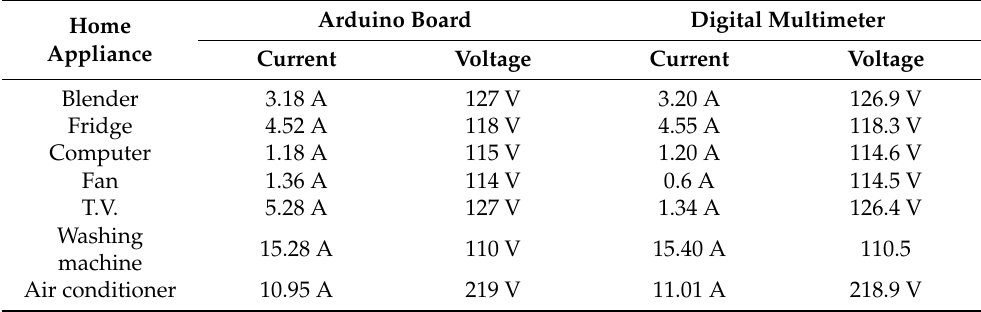
Table 3. Energy consumption